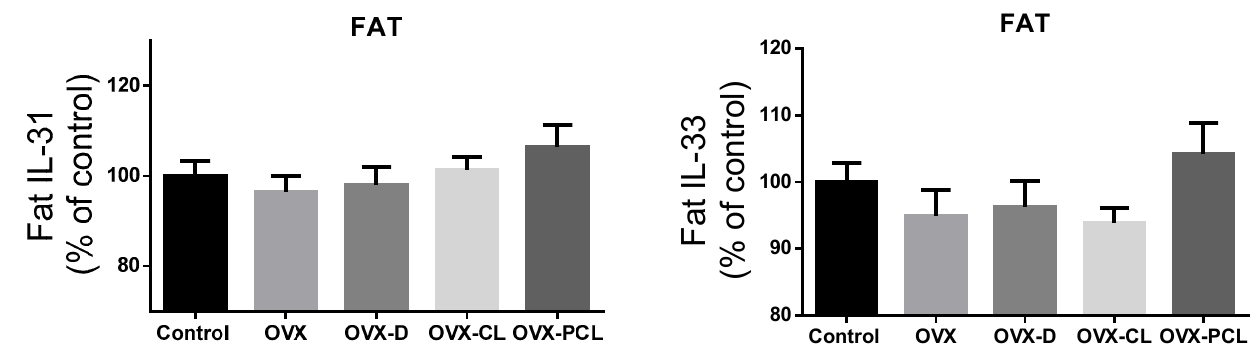
Figure 2. The levels of adipokines and cytokines in the adipose tissue of rats. OVX: ovariectomized group; OVX-D: ovariectomized group with a deprivation of calcium; OVX-CL: ovariectomized group with a deprivation of calcium with the addition of calcium lactate; OVX-PCL: ovariectomized group with a deprivation of calcium with the addition of pumpkin enriched with calcium lactate. IL-31: interleukin 31; IL-33: interleukin 33.